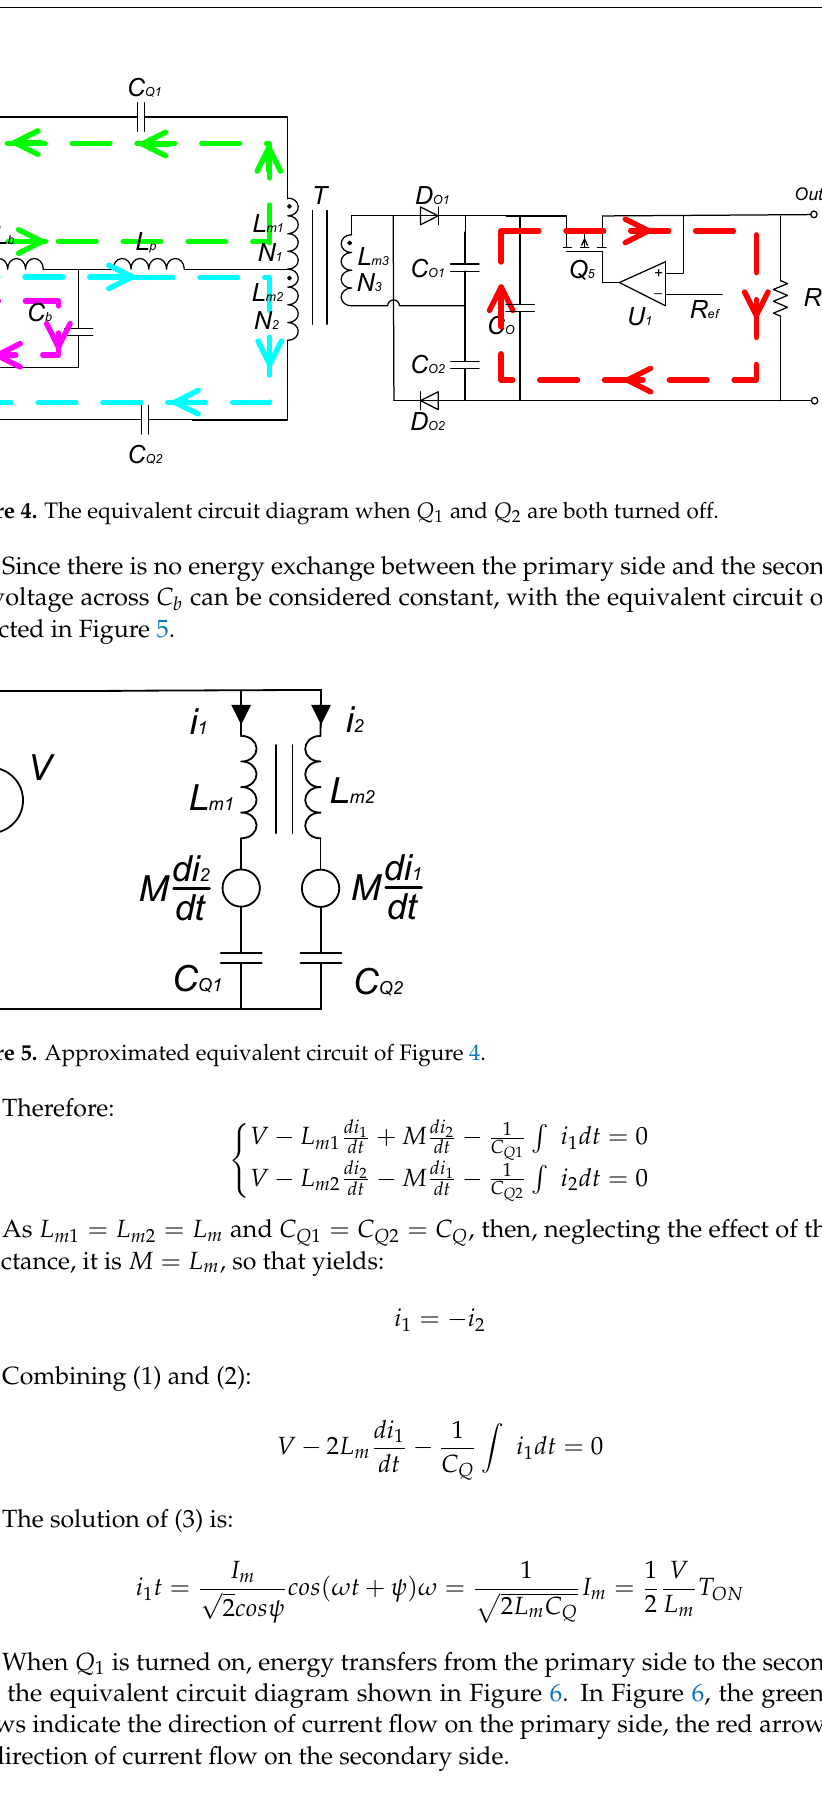
𝑄 𝑅 𝐶 𝐶 (cid:2873) , (cid:3042) , (cid:3042)(cid:2869) , and (cid:3042)(cid:2870) to form a loop.